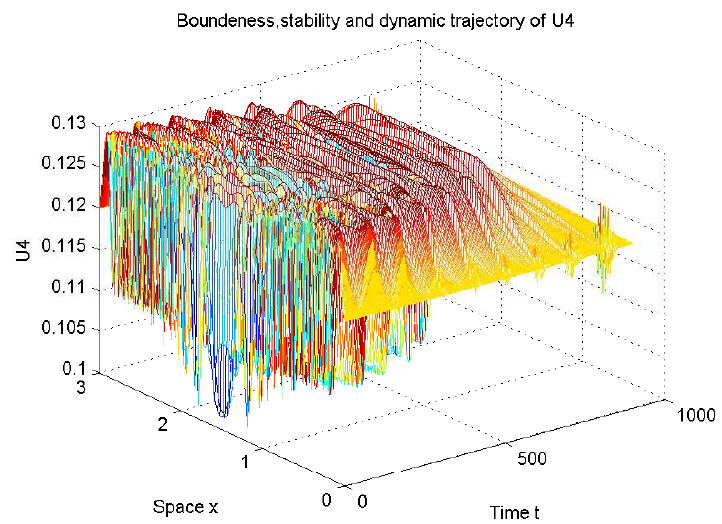
Figure 17. Computer simulation of dynamics of the average profit margin U 4